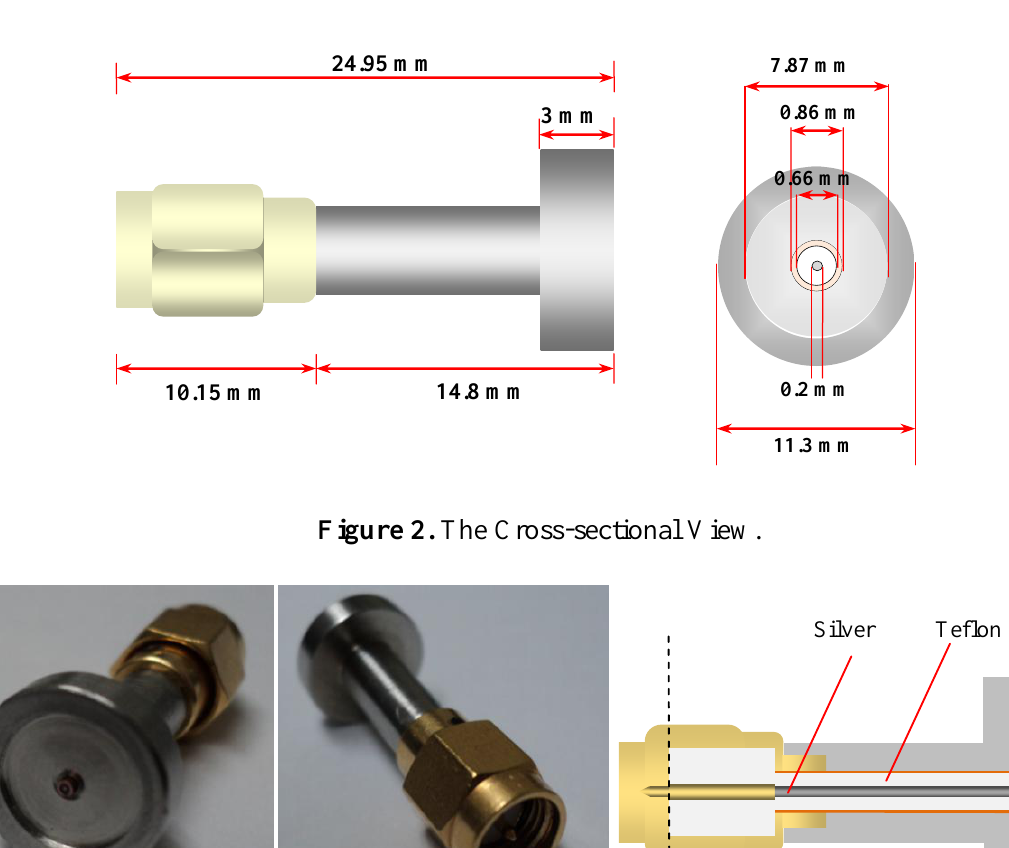
Figure 1. The side sectional view and front sectional view.